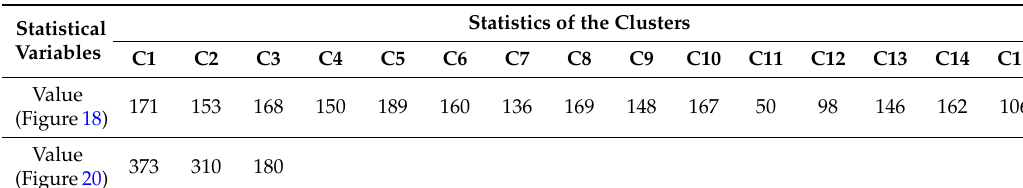
Table 2. Statistics of clusters in Figures 18 and